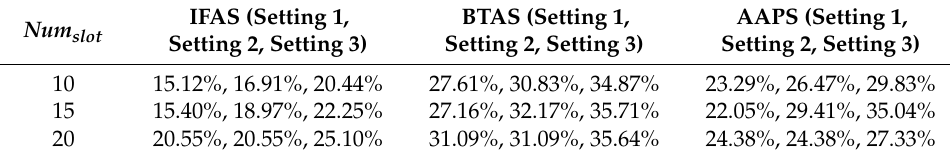
Figure 24. The average energy consumption with Num slot as variable (setting 1, setting 2, setting 3). Table 15. The improvement of energy consumption compared with the traditional algorithm.